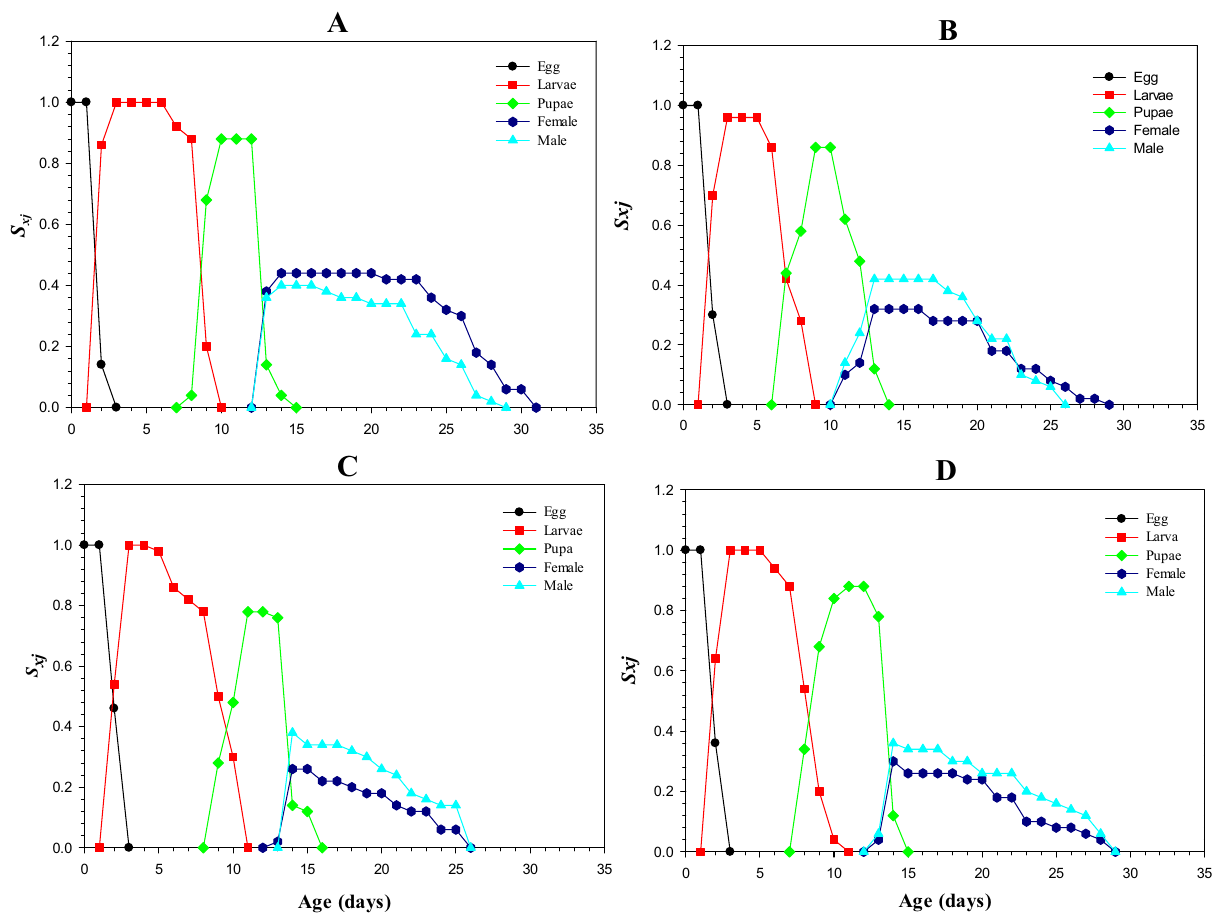
Figure 1. Transgenerational effect of lambda-cyhalothrin, ( A ) control, ( B ) LC 10 , ( C ) LC 30 , and ( D ) LC 50 on Age stage specific survival rate ( S xj ) of Musca domestica.